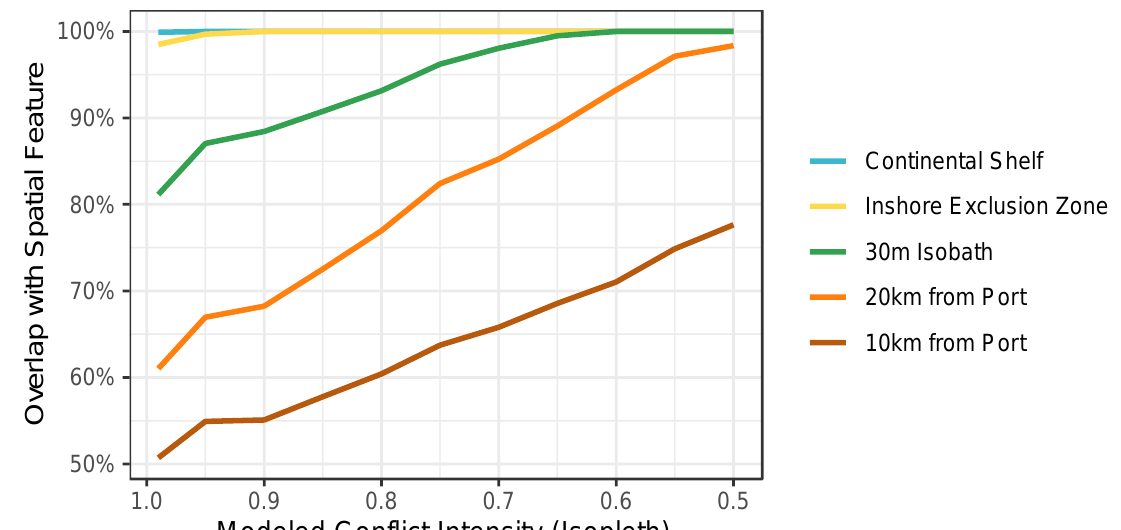
Figure A1.3 : Spatial patterns of conflict between small-scale and industrial fishers in Ghana. This figure illustrates the relationship of conflict intensity (as estimated by calculating the 50%-99% isopleths at intervals of 5%) with spatial features of interest (continental shelf, IEZ, isobath, and port distance). Conflict intensity decreases as the isopleth percentage increases. Overlap on the y-axis corresponds to the percentage of each predicted conflict isopleth that falls within the polygon associated with each spatial feature